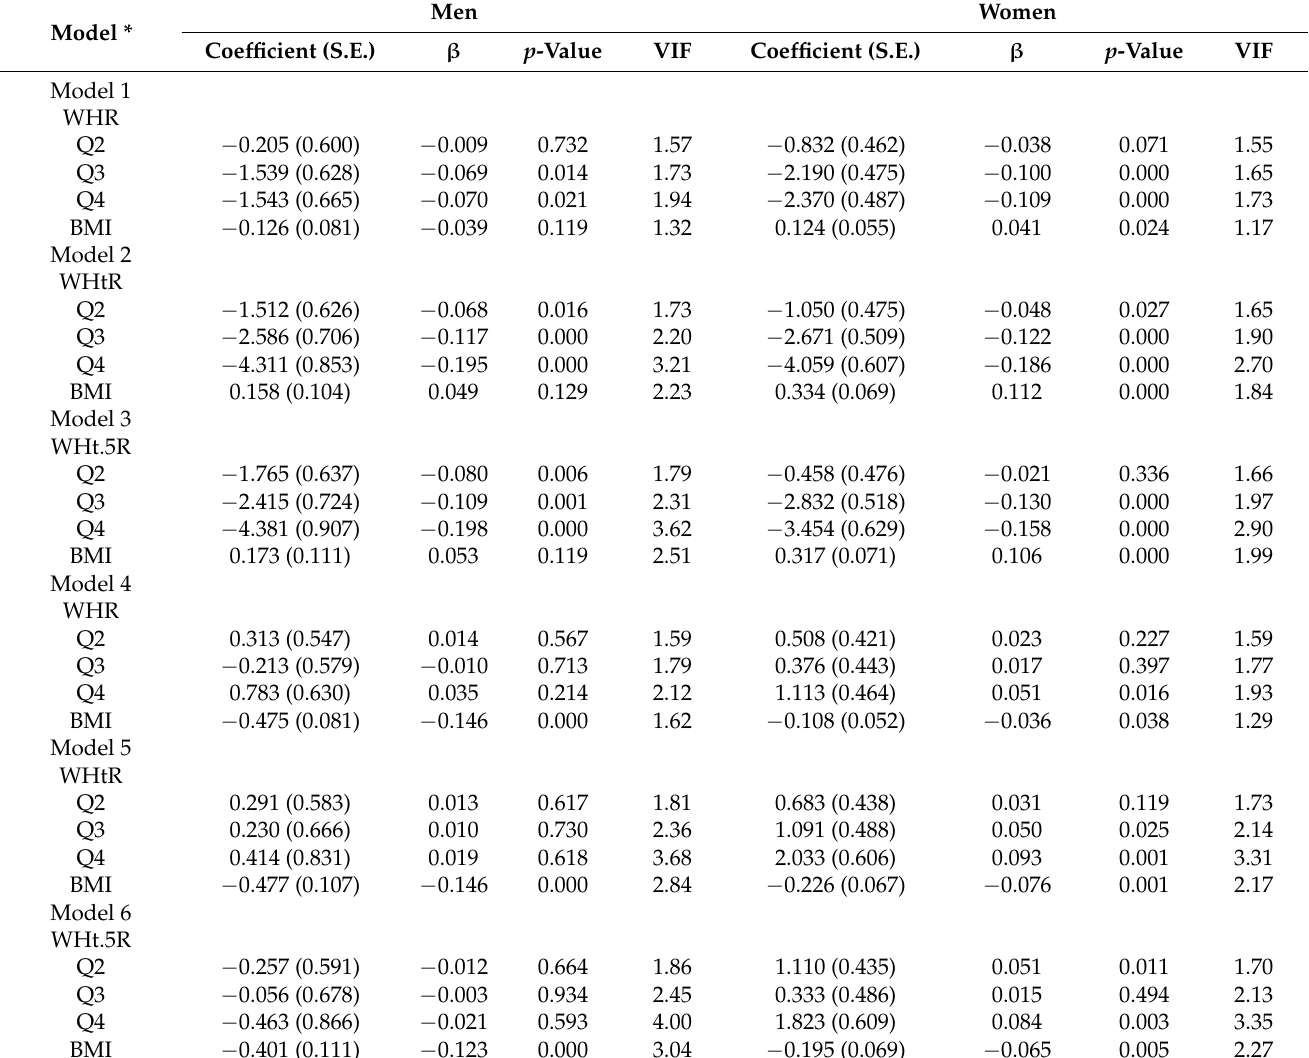
Table 4. Quartile of three waist circumference-related obesity metrics and its association with estimated glomerular filtration rates, compared with the body mass